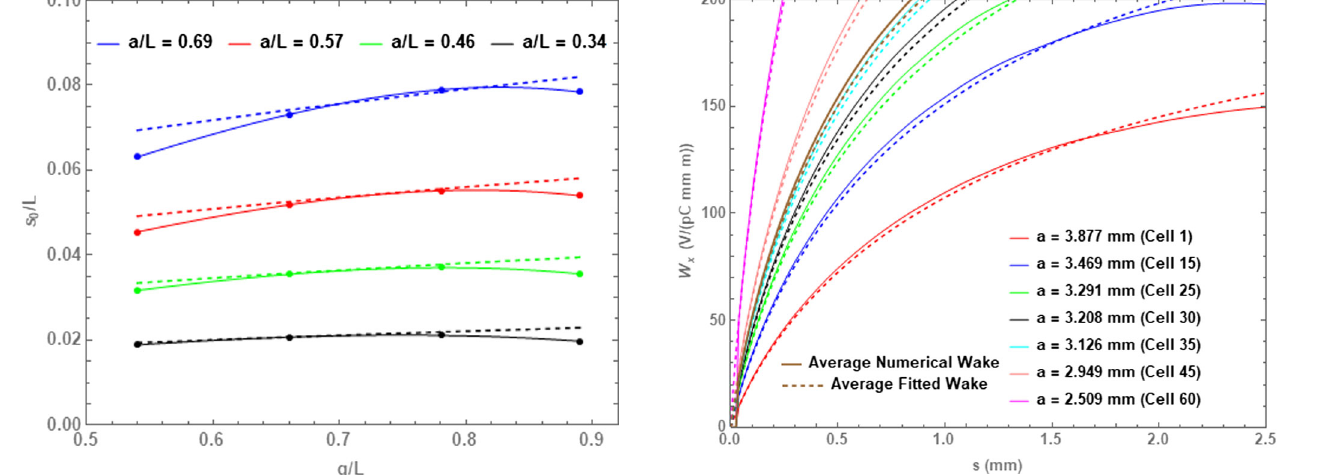
32. Results of a parameter study to calculate s 0 for the transverse wake by use of the CFD code for 16 points (dots) chosen with in the ranges 0 . 34 ≤ a=L ≤ 0 . 69 and 0 . 54 ≤ g=L ≤ 0 . 89 . Interpolation of these points are shown by a solid line. A fit of Eq. (46) with μ ¼ 0 . 169 , β ¼ 1 . 80 , γ ¼ 0 . 3335 , and δ ¼ 1 . 13 are shown by dashed